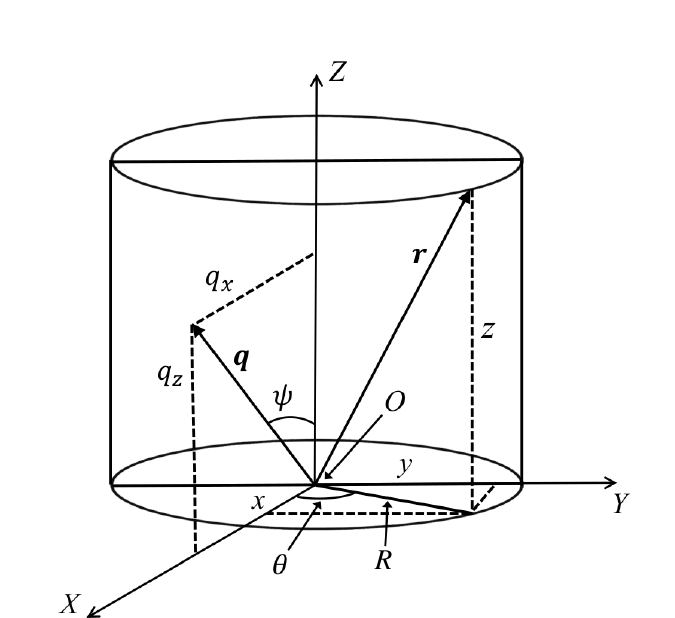
Figure 2. Representation of scattering and position vectors q (situated in XZ plane, i.e., q y = 0) and r in cylindrical coordinates, respectively. Here, ( x , y , z ) and ( R , θ , z ) are the rectangular and respectively cylindrical coordinates of the vector r in real space, where θ is the angle between the projection of vector r in the XY plane and the positive direction of X axis. The components of q are ( q , ψ , ζ = q z ) in rectangular and cylindrical coordinates, respectively. ψ is the angle between the vector q and the positive direction of Z